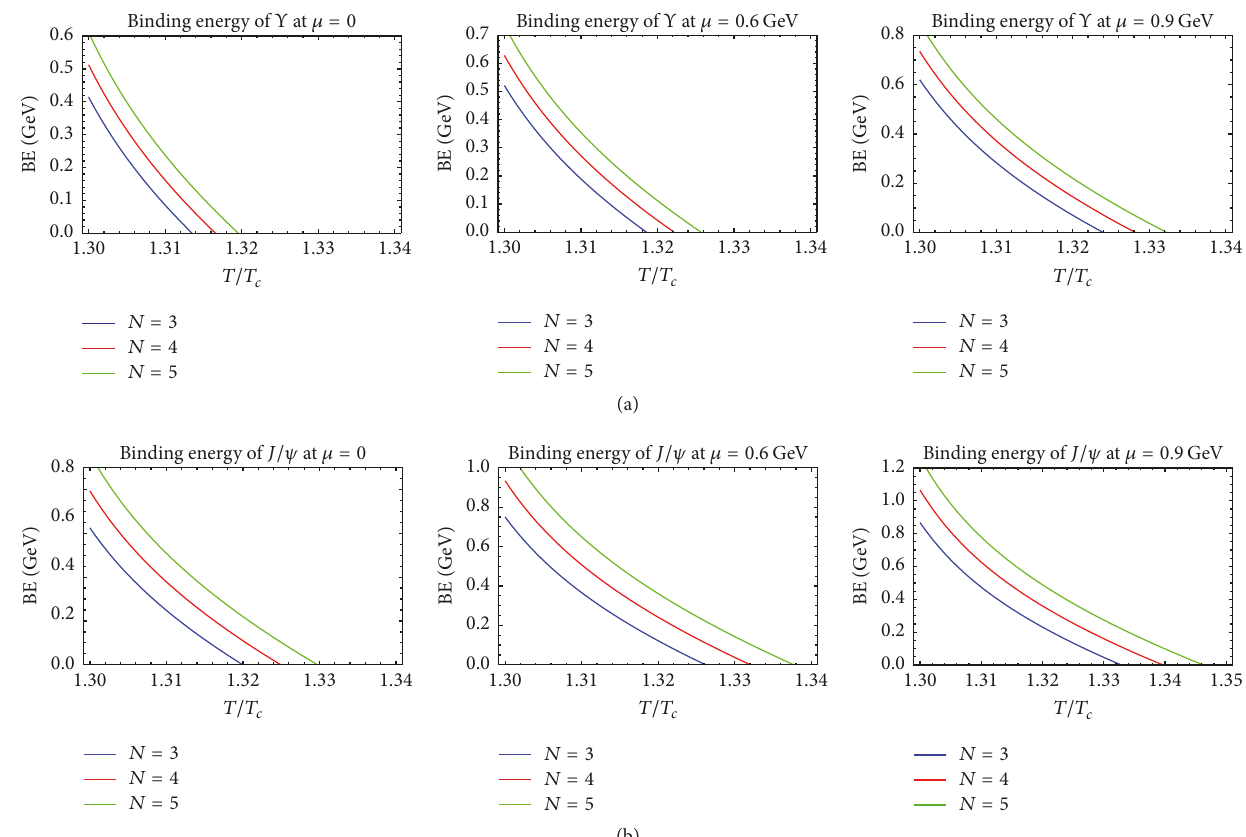
Figure6:Dependenceof Υ bindingenergy(inGeV)ontemperature 𝑇/𝑇 𝑐 (a)anddependenceof 𝐽/𝜓 bindingenergy(inGeV)ontemperature 𝑇/𝑇 𝑁 . 𝑐 (b) at different values of